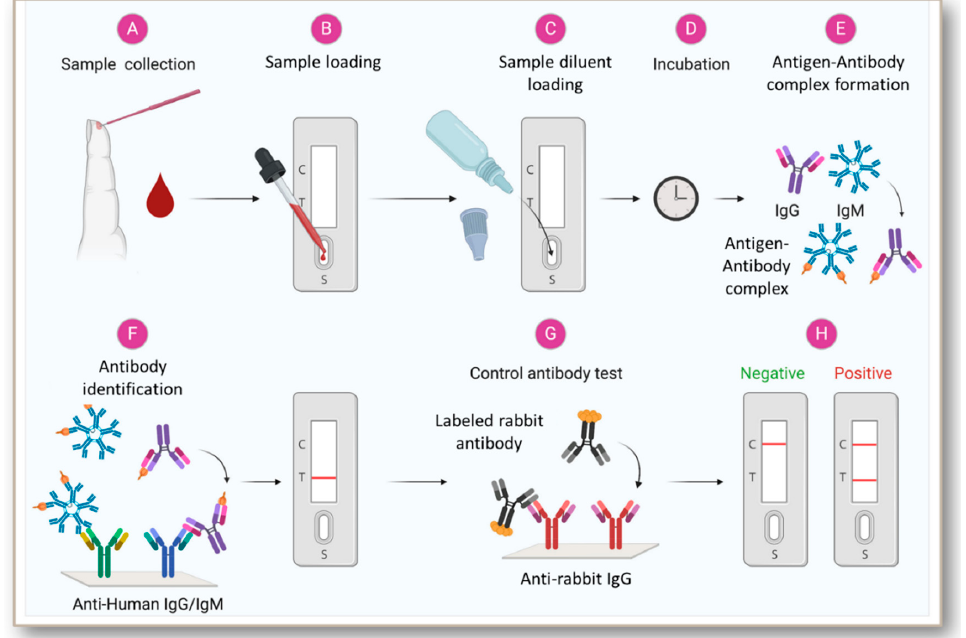
Figure 2. Scheme showing the general steps in the antibody-based diagnosis of viral infections from